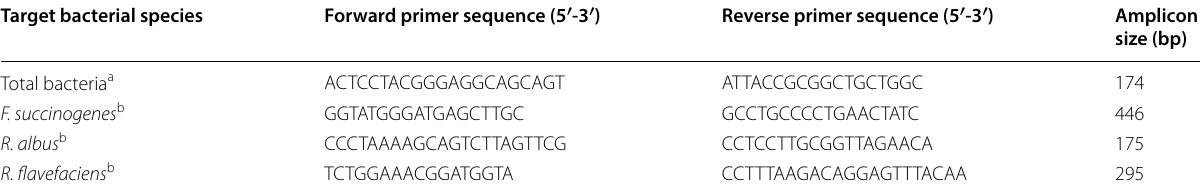
F. succinogenes , Fibrobacter succinogenes ; R. albus , Ruminococcus albus ; R. flavefaciens , Ruminococcus flavefaciens a Schwiertz et al. (2010) b Koike and Kobayashi (2001)